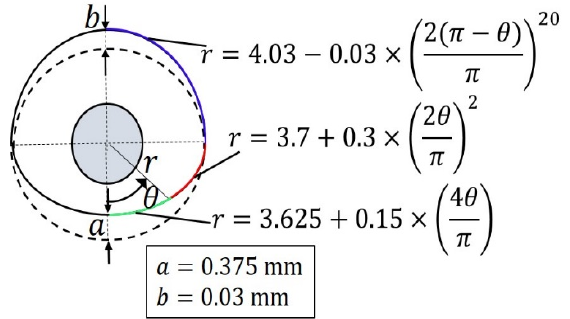
Figure 8. Cam design of newly developed prototype.